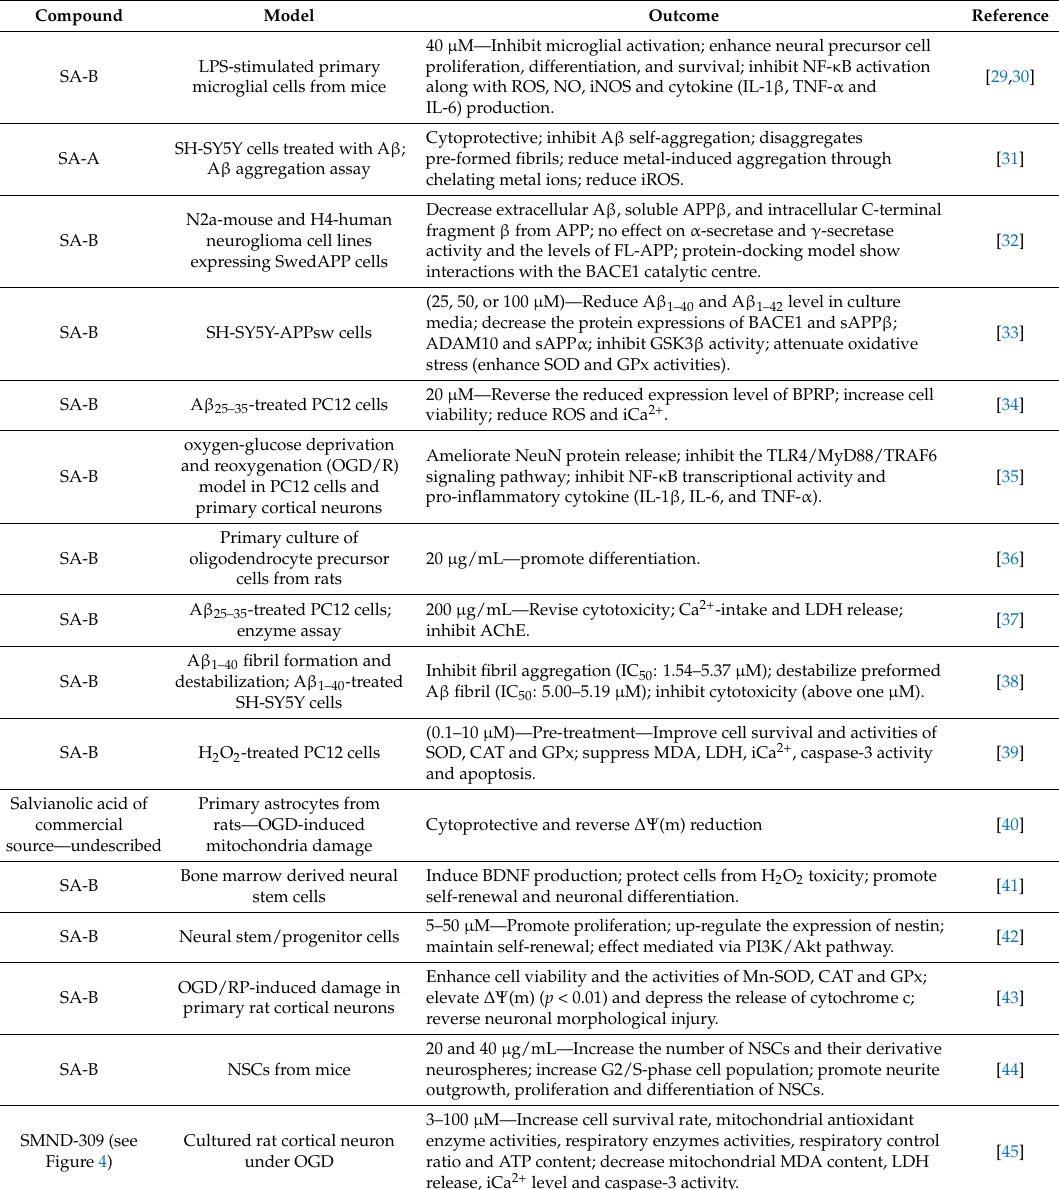
Table 1. In vitro neuroprotective effects of Salvianolic